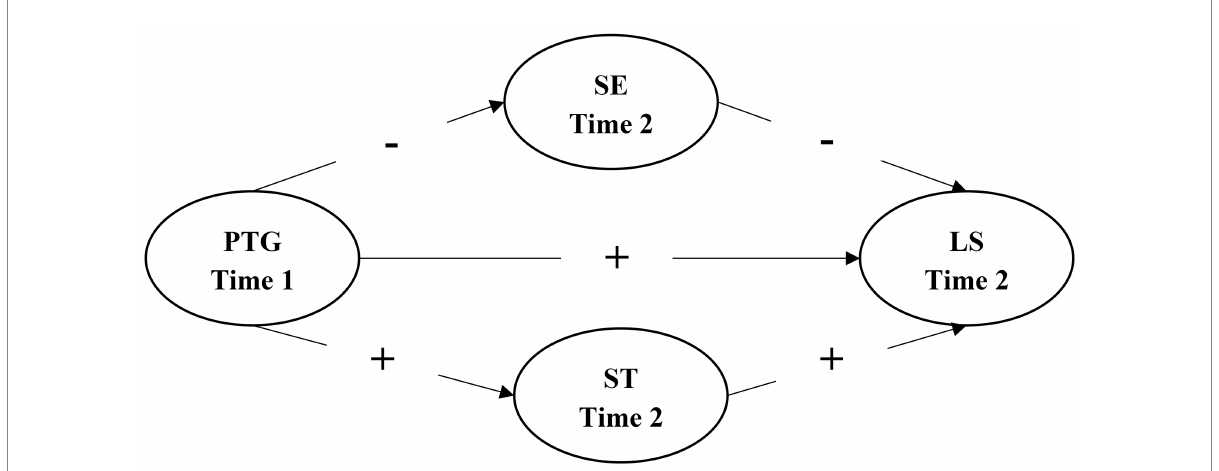
FIGURE 1 Hypothesized structural equation model of the relationships between the COVID-19 related posttraumatic growth (PTG), life satisfaction (LS), self-enhancement value (SE), and self-transcendence value (ST). Time 1 = the peak phase of the COVID-19 pandemic in China, Time 2 = the post- pandemic phase of the COVID-19 in